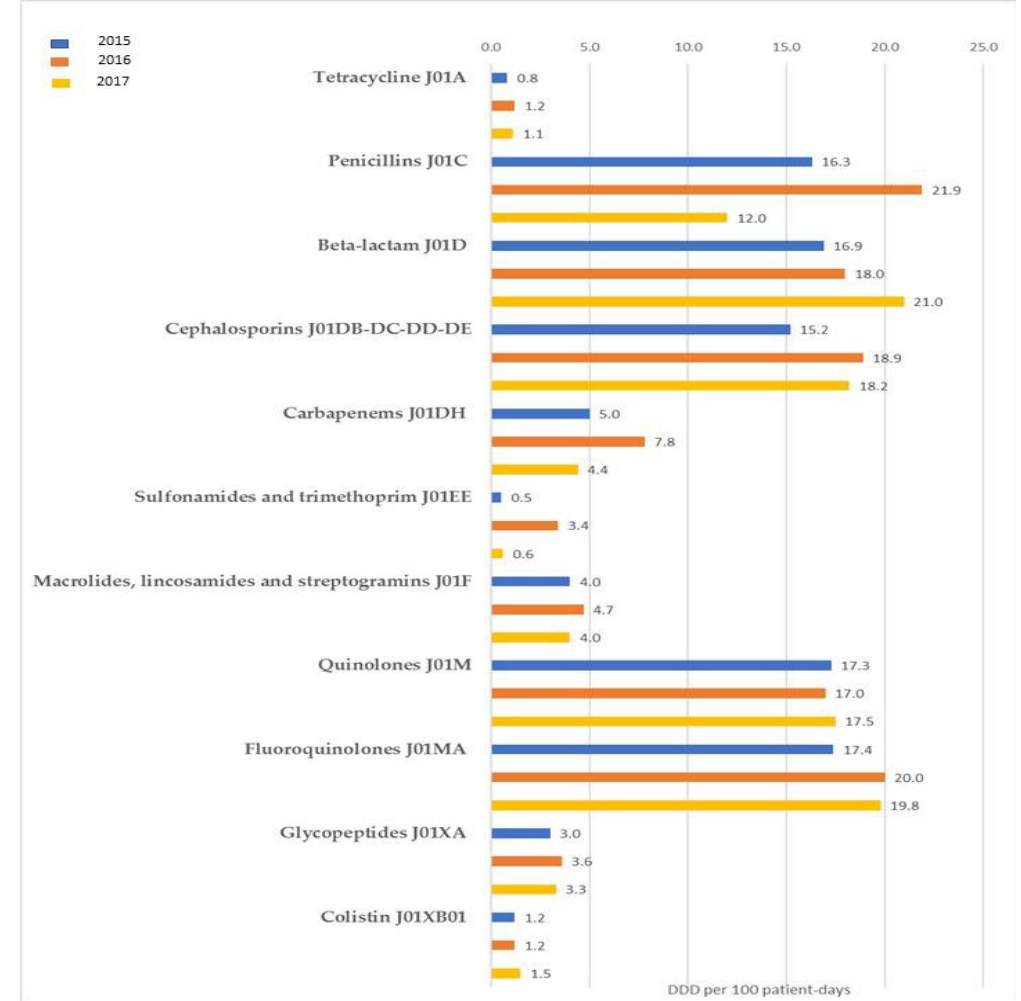
Figure 1. Consumption of antibiotics in healthcare facilities (expressed as Defined Daily Dose per 100 patient-days) by Anatomical Therapeutic Classification groups in 2015 (A), 2016 (B), and 2017 (C), in Sicily (Southern Italy). (All healthcare facilities).